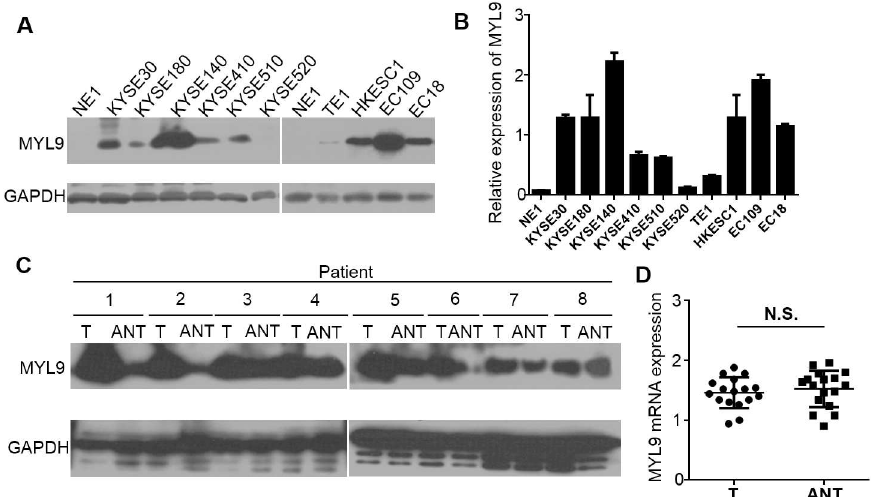
Fig 1. Western blotting and qPCR analyses of MYL9 expression in ESCC cell lines and tissues. (A) MYL9 protein and(B) mRNA expressionlevelsin NE1 and ESCC cell lines. Expression levelswerenormalized againstGAPDH. Error bars representthe standarddeviationof the mean (SD), whichwas calculatedfrom three parallelexperiments. (C) Representative westernblots of MYL9 proteinexpressionin eight matched pairs of ESCC tissues (T) andadjacentnoncancerous tissues (ANT). GAPDH was used as the loadingcontrol. (D) Statistical analysesof MYL9 mRNA expression in matchedpairedT and ANT. N.S., not significant.